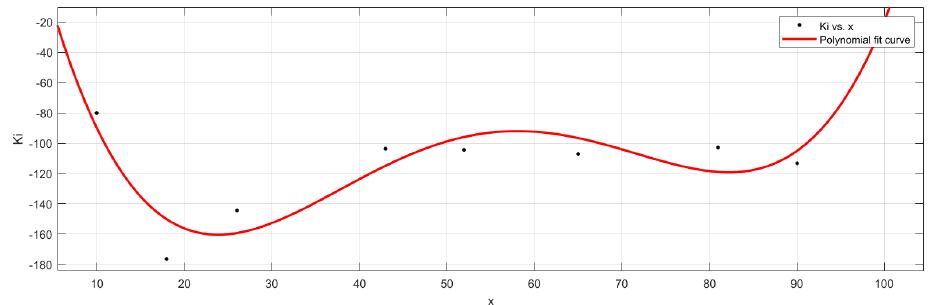
Figure 12. Determined K i vs. % p.u load(x) and the fitted curve.